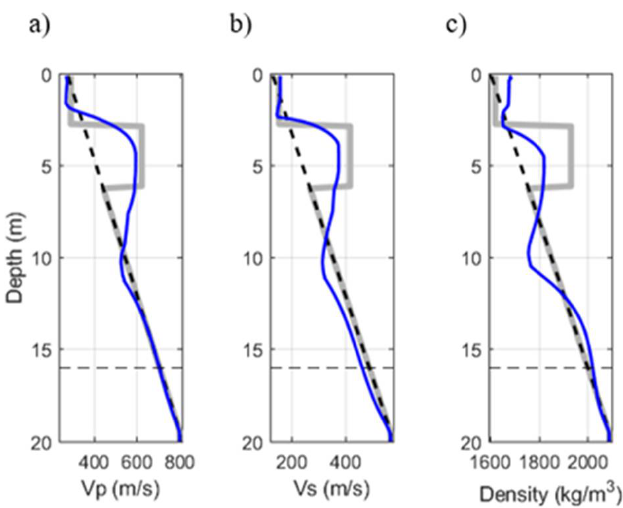
Figure 4. Model fitting when using a low-frequency source signal: ( a ) vertical profiles of the P- wave velocity model, ( b ) vertical profiles of the S- wave velocity model, and ( c ) vertical profiles of the density model. The true model is plotted with the grey line, the initial model is represented by the dashed black line and vertical profile at x = 25 m of the inverted models is the plotted blue line.